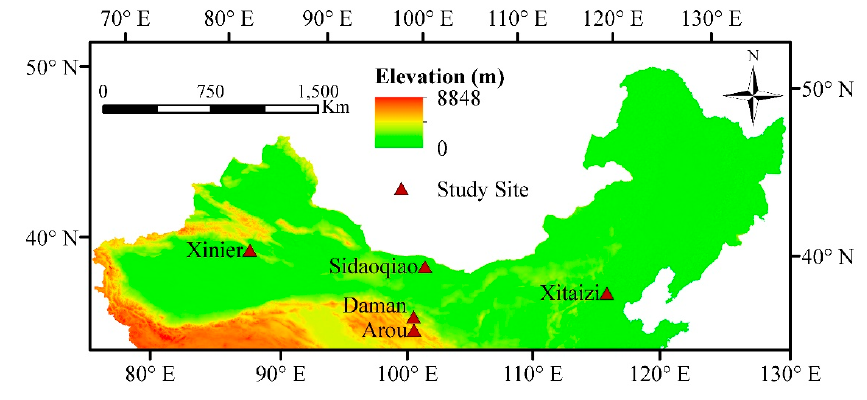
Figure 1. Location of the five sites.